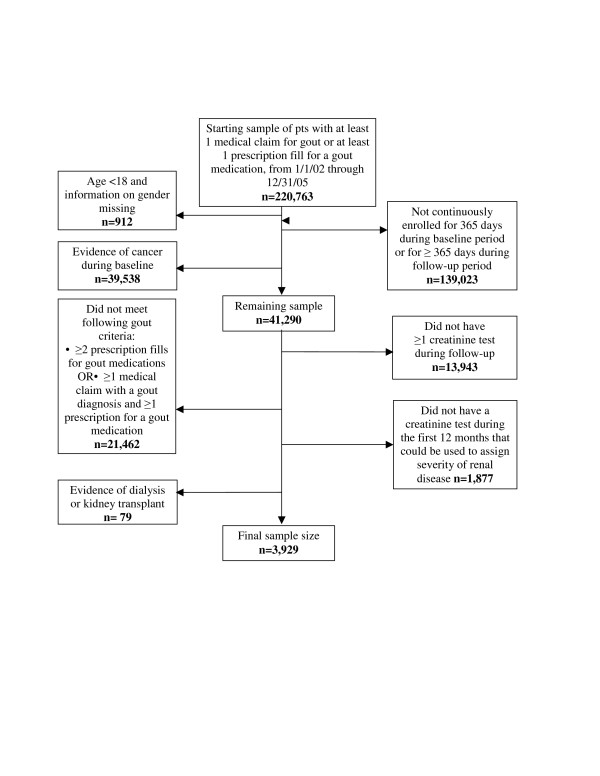
Patient selection. A total of 220,763 patients with at least 1 medical claim for gout or 1 fill for gout medication between 1/1/02 and 12/31/05 were initially identified from the health plan database. After application of all inclusion and exclusion criteria, a final sample of 3,929 patients was selected for the study.